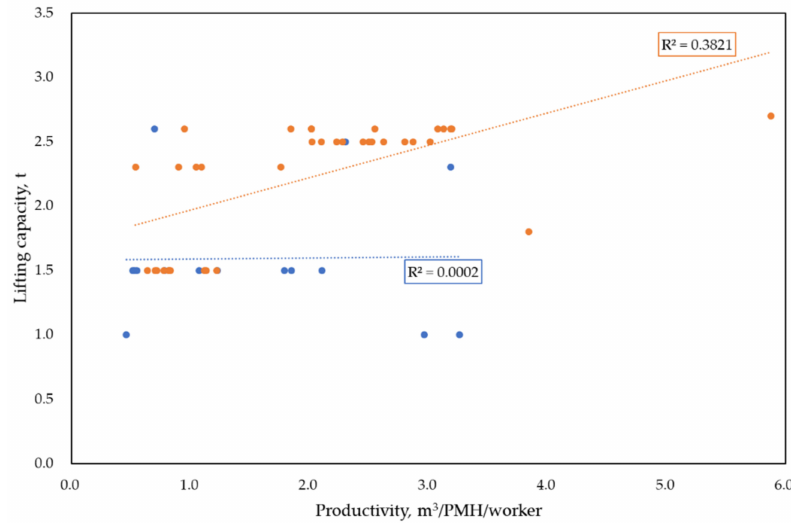
Figure 6. Productivity relationship with the lifting capacity. Productivity had a moderate correlation with two independent variables in clear-cut, whereas it had no correlation in the thinning operation.